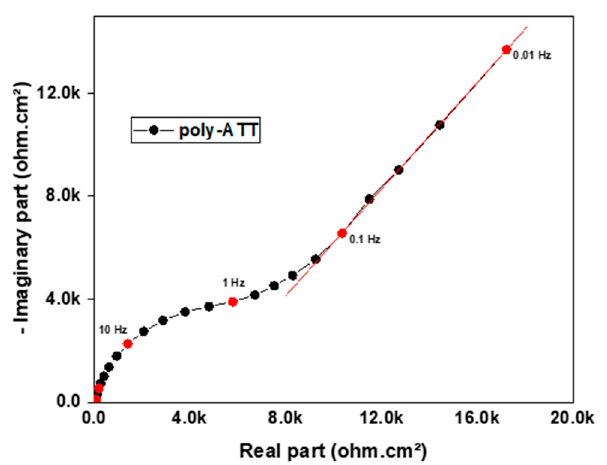
Figure 9. Nyquist diagram recorded with poly-ATT/60Cu-40Zn at abandonment potential in 0.1 M KOH/CH 3 OH. Table 3. Electrochemical parameters obtained by the SIE of the interface 60Cu-40Zn/ poly-ATT in a medium 0.1 M KOH + CH 3